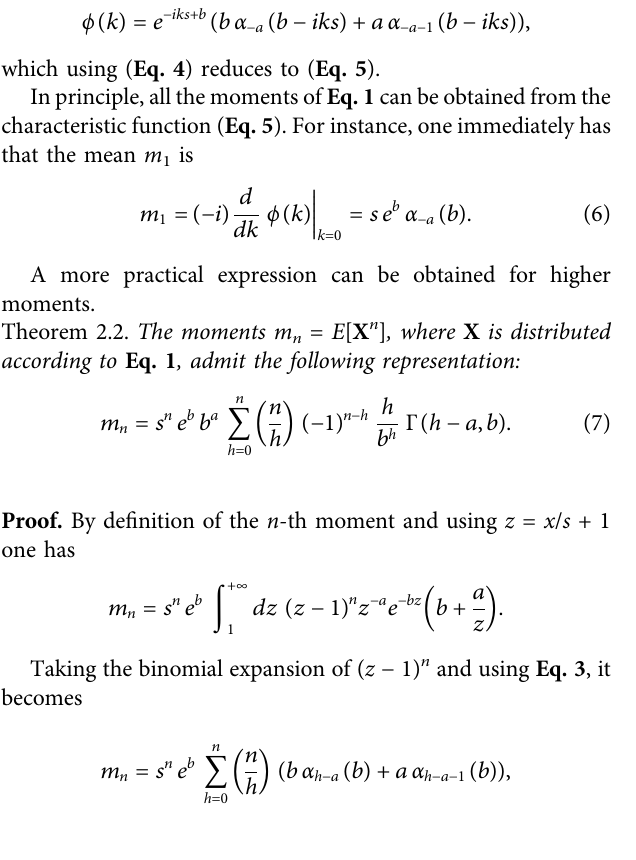
Frontiers in Physics |